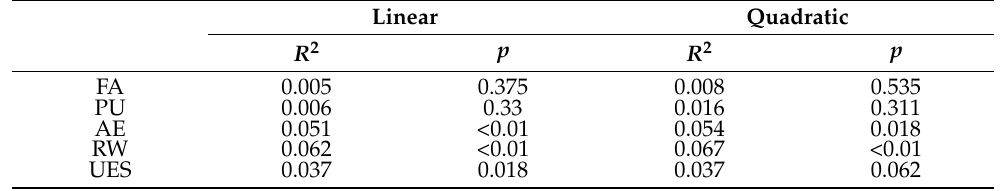
Table 5. Lighting Key in relation to user engagement scale (short form) for the linear and quadratic model.